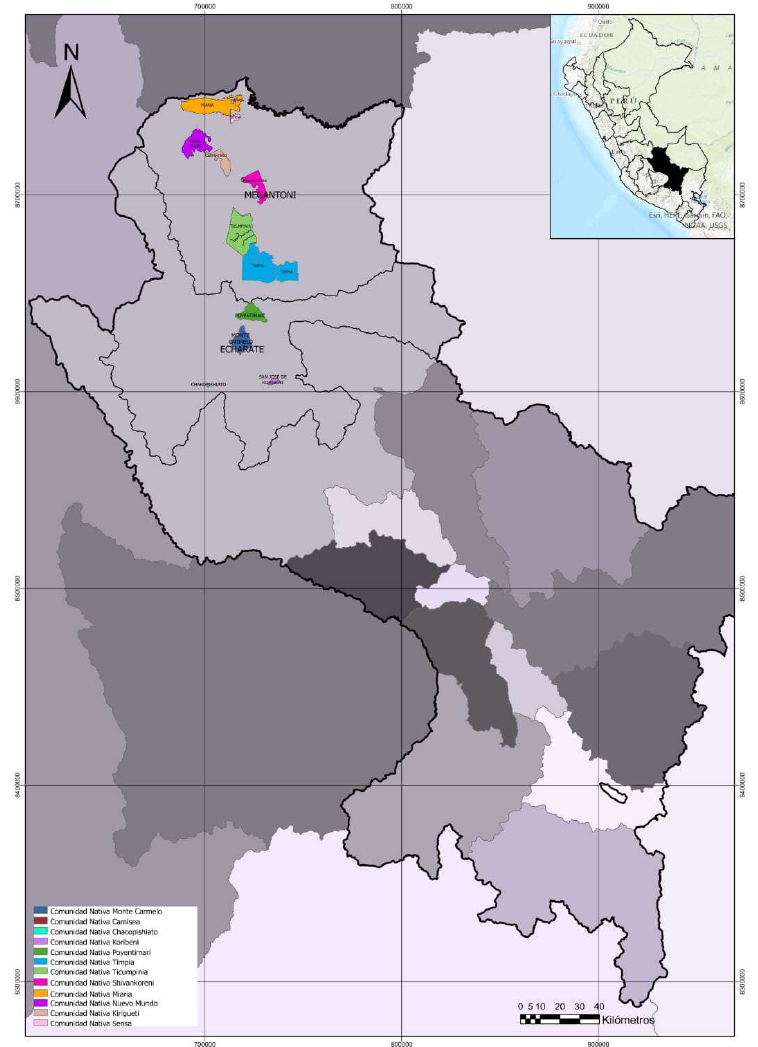
Figure 7. Distribution of collection sites for Gossypium spp. in the districts of Echarati and Megantoni, in the Cusco region, in the province of La Convención, Peru.